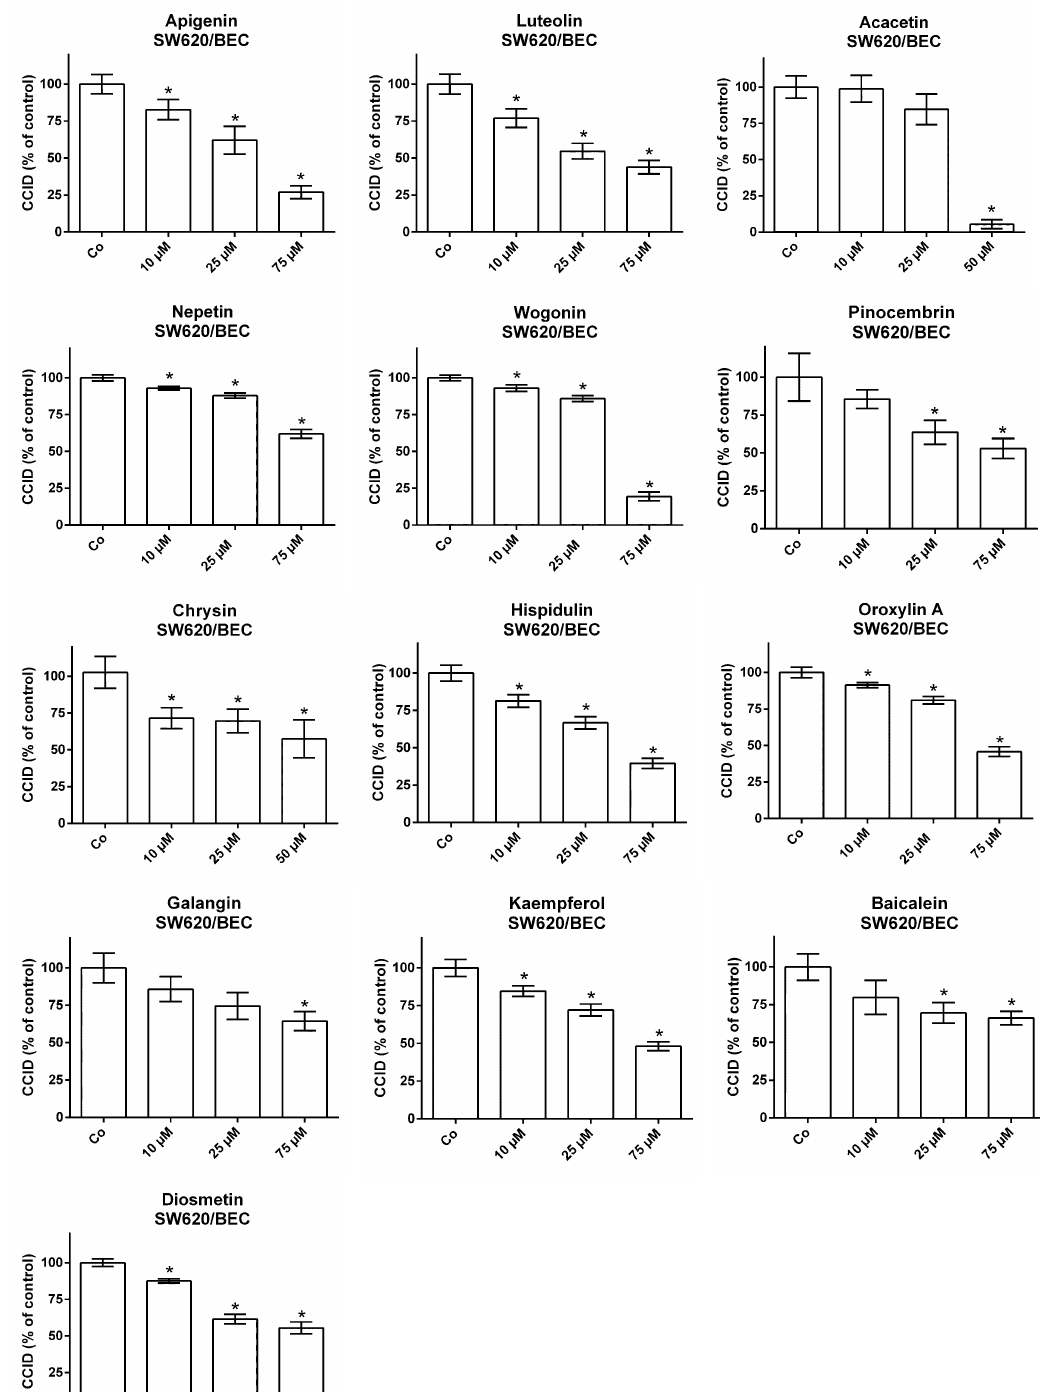
Figure 2. SW620 spheroids were pre-treated for 20 min with solvent (DMSO; Co) or the indicated concentrations of each flavonoid before placement on blood endothelial cell (BEC) monolayers and co-cultivation for 4 h. Then CCIDs were measured. Three parallel experiments were performed. For each concentration, a total of 15 replicates was analyzed. * p < 0.05.